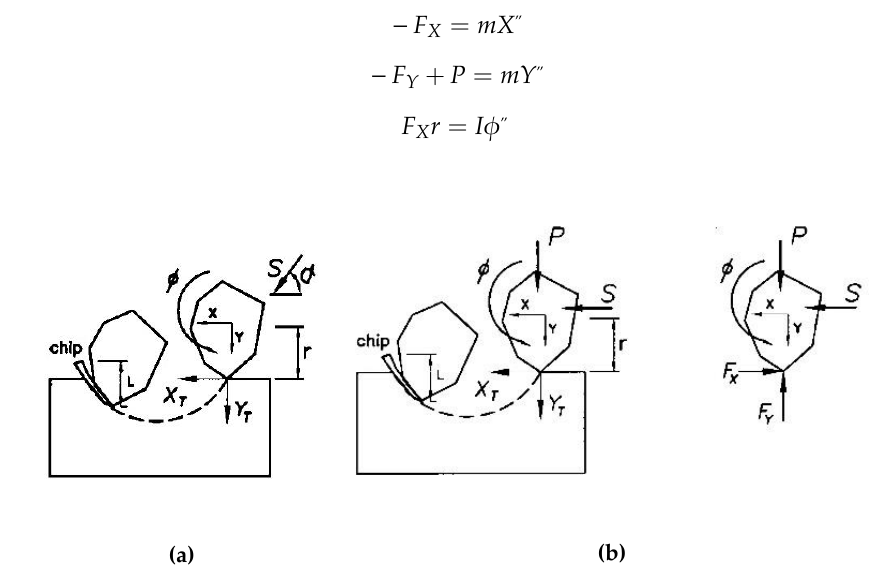
Figure 5. Schematic diagram of a two-dimensional cutting process using an abrasive particle: ( a ) inertial force only; ( b ) working load (P); and wire speed (S).